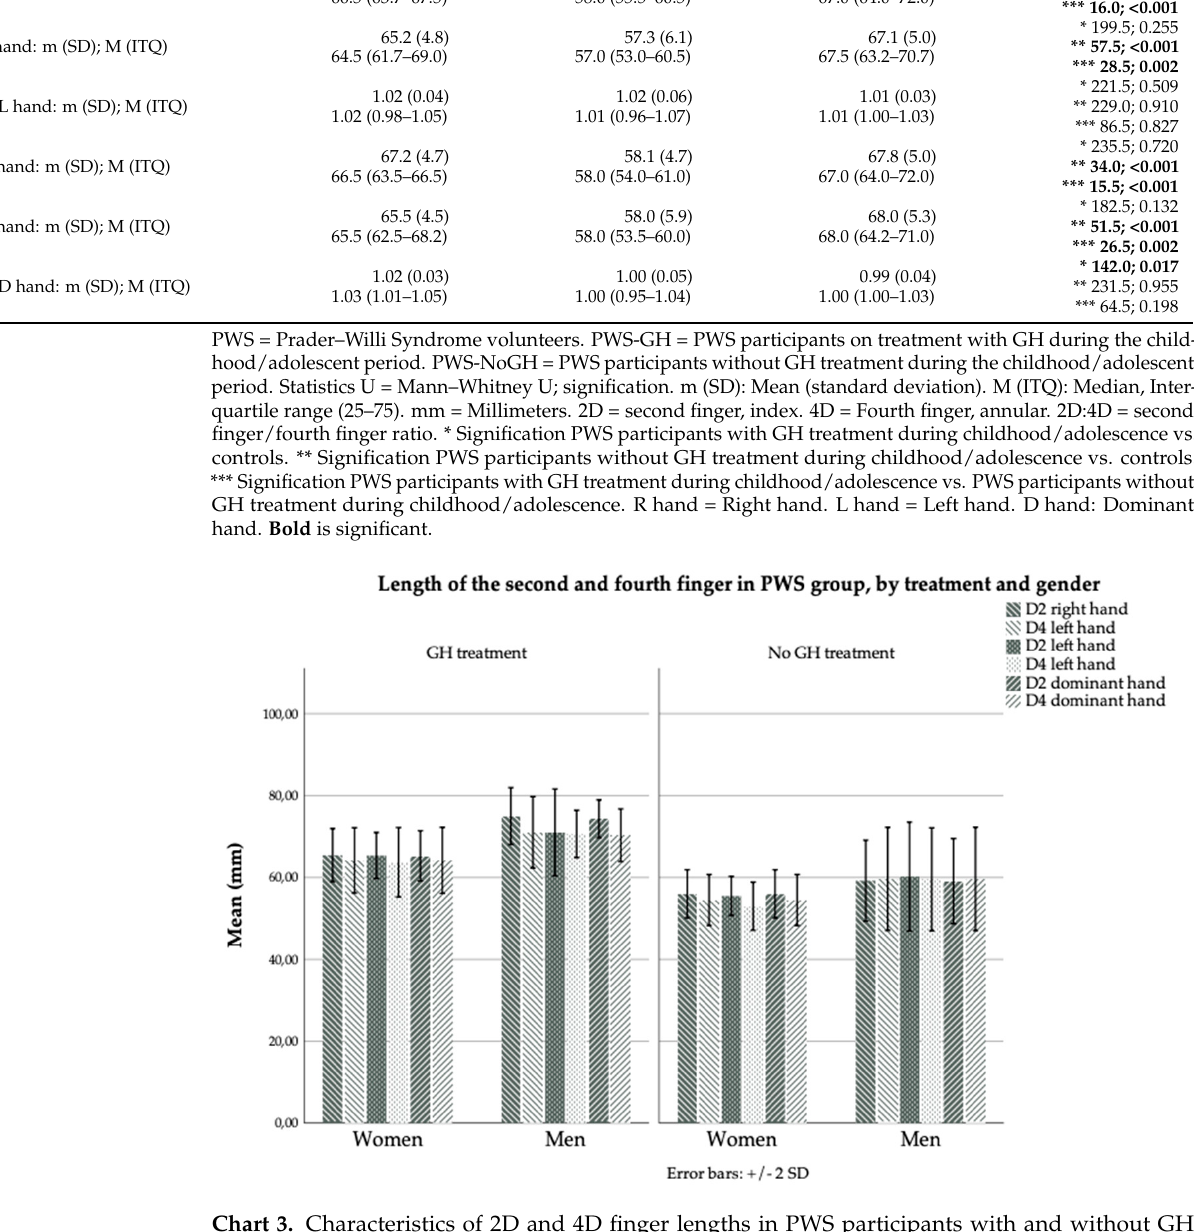
67.1 (5.0) 67.5 (63.2–70.7)